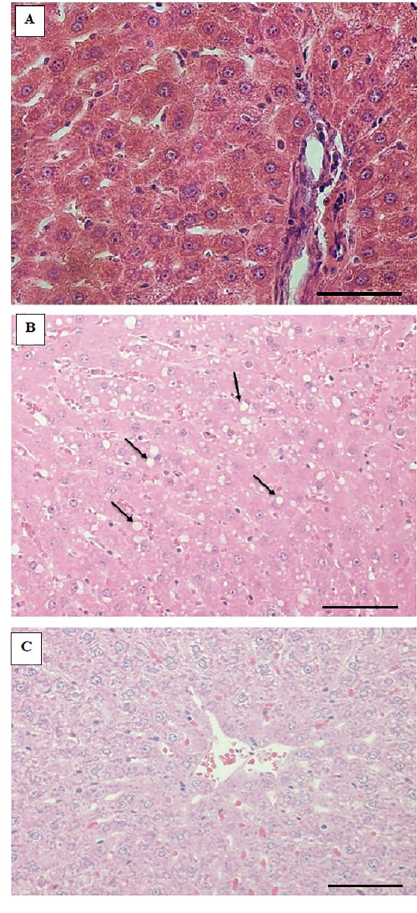
Figure 1. Histopathological changes in normal, high fat-carbohy- drate diet (HFCD) and HFCD + pioglitazone groups. A , Normal hepatocytes without in fl ammatory cells. B , Microscopic photo of the liver presented numerous fat droplet (arrows) among and within the liver cells, with associated deteriorating changes in hepato- cytes in the HFCD group. C , Normal hepatocytes without in fl am- matory cells and low fat globules in the HFCD + pioglitazone group. H&E stain, magni fi cation 20 (cid:1) , scale bar 200 m